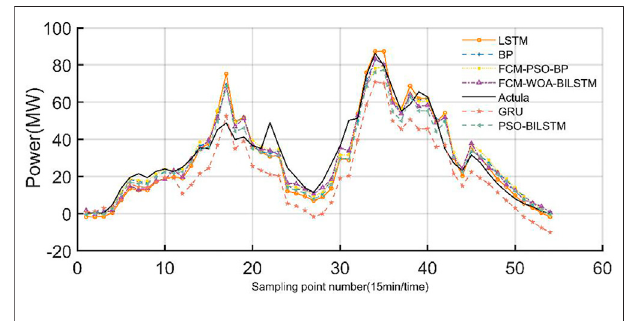
FIGURE 9 | 18 July 2019